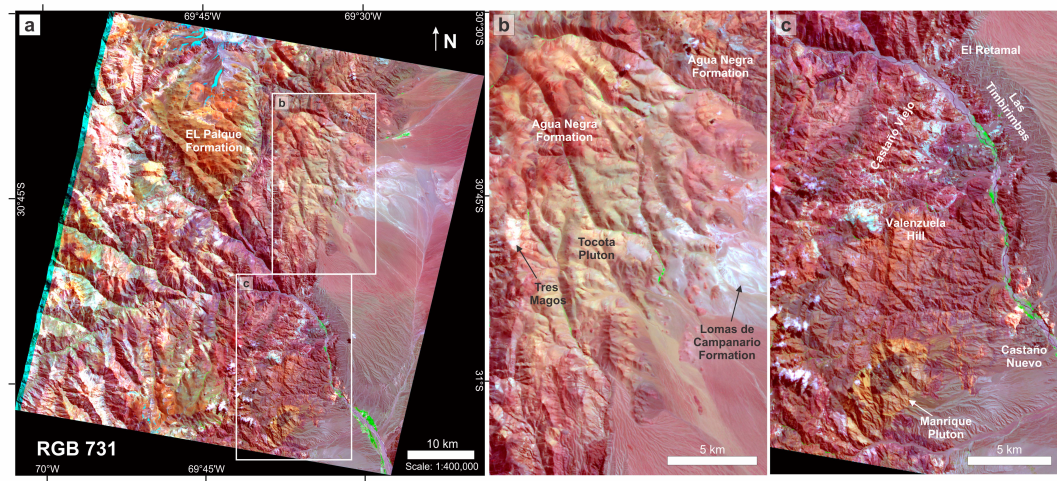
Figure A2. ( a ) False color composite image with ASTER bands 7, 3, 1 (RGB). ( b ) The San Francisco de los Andes district: Tocota pluton (greenish grey), Loma del Campanario (bluish white), Agua Negra Formation (reddish maroon), and Tres Magos alteration zone (white). ( c ) The Castaño area: argillic – phyllic alteration (light blue) and silicic alteration (pink orange), Manrique Pluton and rhyolitic dykes (light brown). Compare the current ASTER imagery with the geologic map in Figure